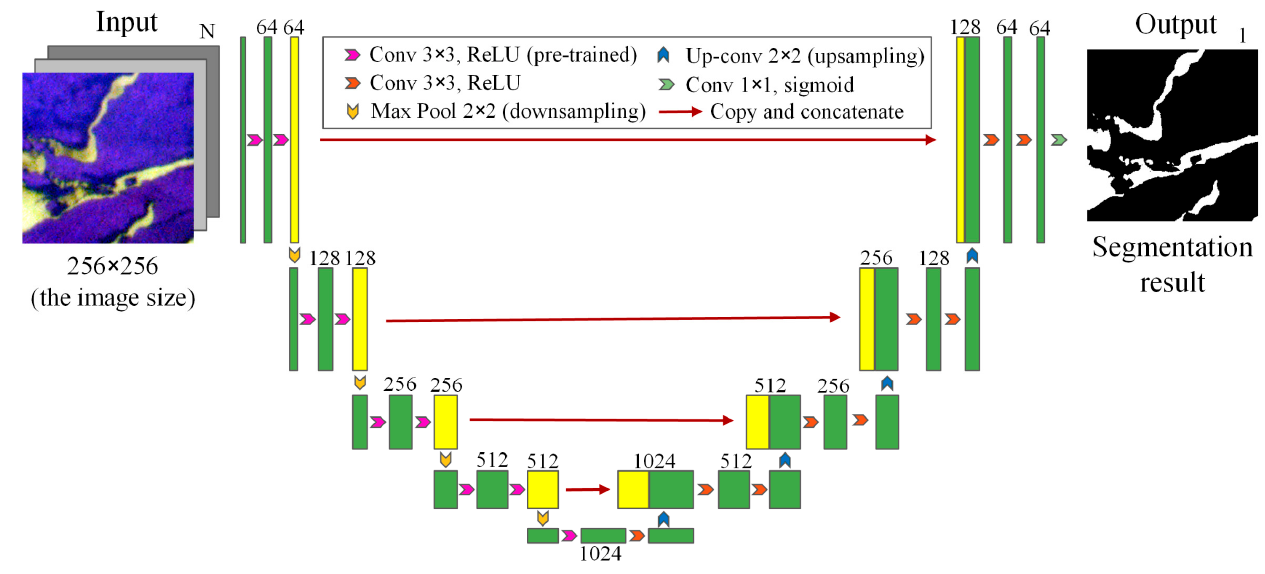
Figure 4. Detailed architecture diagram of the VGGUnet model. The N in the upper-right corner of the input image indicates that the input image has N spectral bands. For instance, the Super Dove image includes four bands (Blue-Green-Red-Nir), and the UAV image has three bands (Blue-Green-Red). The 1 in the upper-right corner of the output image indicates that the output image is a single-band image containing U. prolifera pixels.